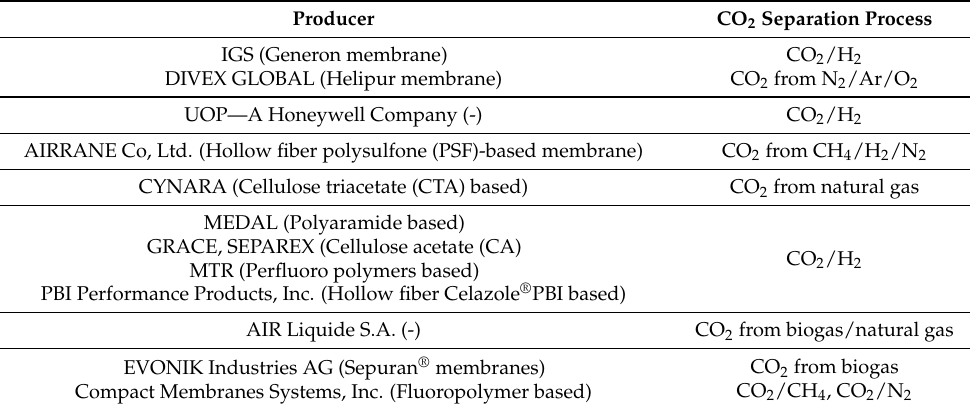
Table 1. Polymeric membrane producers for CO 2 separation available in the market [11]. Producer CO 2 Separation